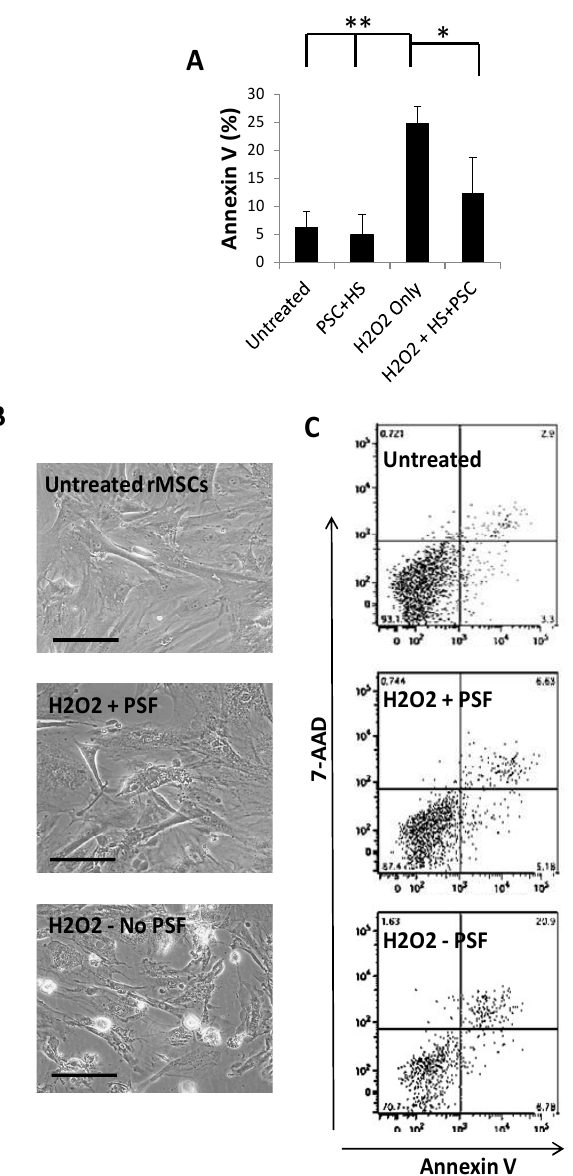
Figure 2. Annexin V staining analysis of apoptosis with in vitro stress assays. ( A ) Compiled results of GFP-rMSC apoptosis at 1 h following addition of hydrogen peroxide to culture medium. ( B ) Representative images of GFP-rMSCs apoptosis for in vitro stress assays. ( C ) Representative flow cytometry results of staining for annexin V. Untreated-2.9% apoptotic, PSF + H 2 O 2 treated-5.6% apoptotic, H 2 O 2 treated-20.9% apoptotic. Samples were in triplicate and performed on two occasions. ** indicates p < 0.5 H 2 O 2 treated compared with untreated or PSF, * indicates p < 0.5 H 2 O 2 treated compared with PSF treated MSCs. Bar =100 µ